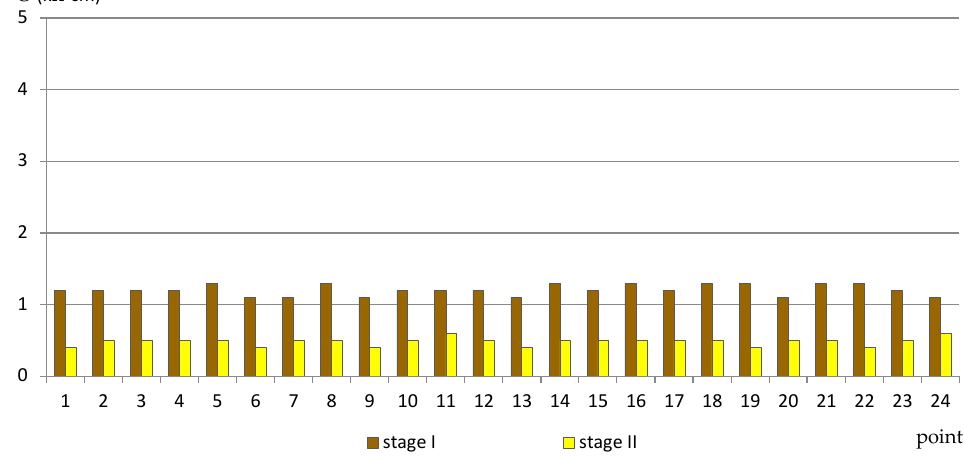
Figure 12. Concrete cover resistivity measured in C_I_n specimens.